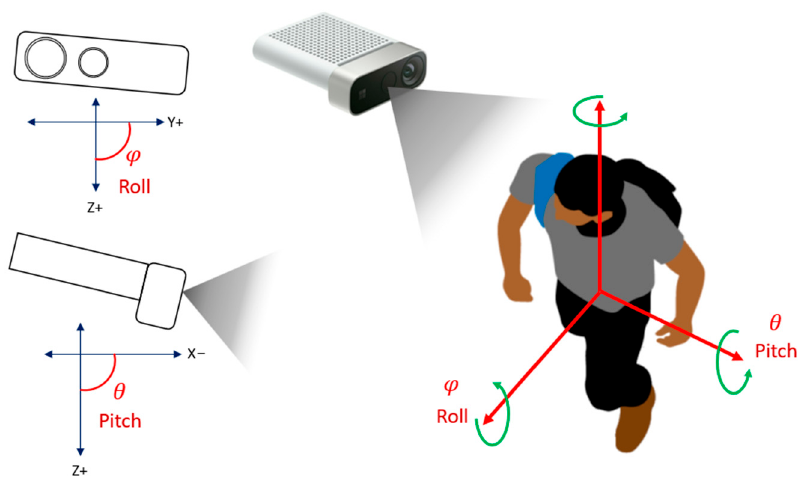
Figure 6. Pitch and roll angles from the camera and human body perspective correction.